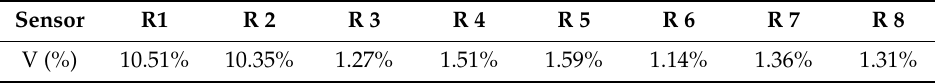
Table 21. The measured concentration volume fraction of the rectangular deployment scheme. Table 22. The measured concentration volume fraction of the sector deployment scheme.